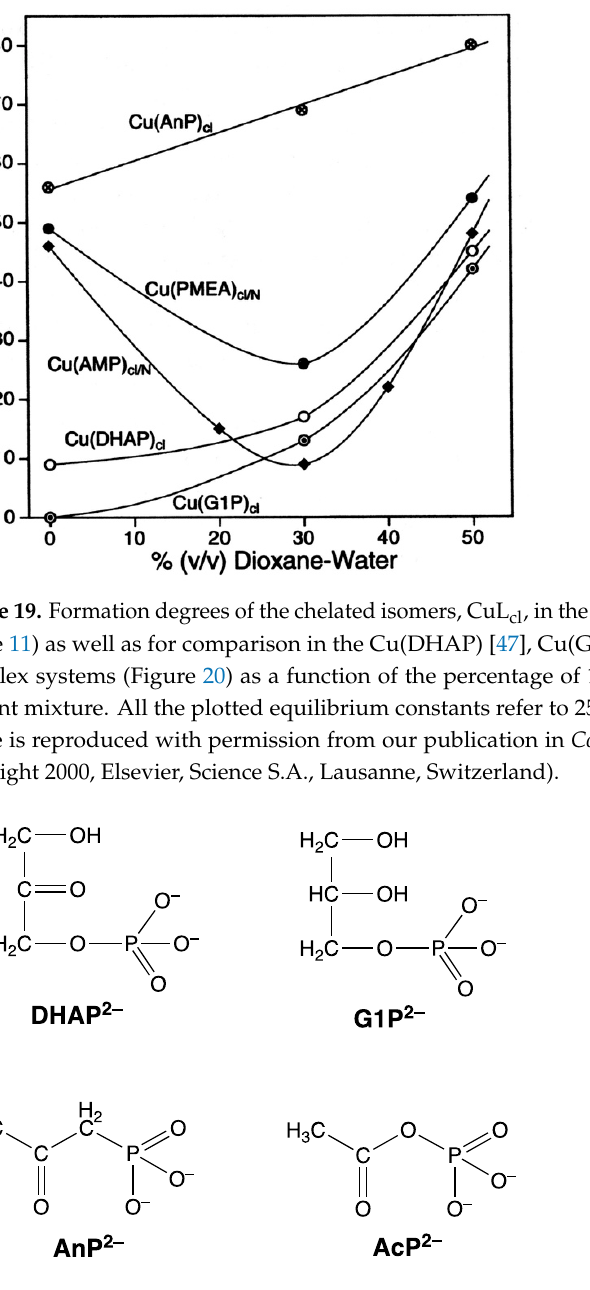
Figure 20. Chemical structures of dihydroxyacetone phosphate (DHAP 2 − ) and glycerol 1-phosphate (G1P) 2 − . Acetonylphosphonate (AnP 2 − ) is often employed as a model compound for acetyl phosphate (AcP 2 − ), which is biologically very relevant but difficult to study because it is very hydrolysis-sensi- tive. It may be added that in the so-called [155] α -glycerophosphate shuttle, DHAP 2 − and G1P 2 − are interconverted into each other [155,156].